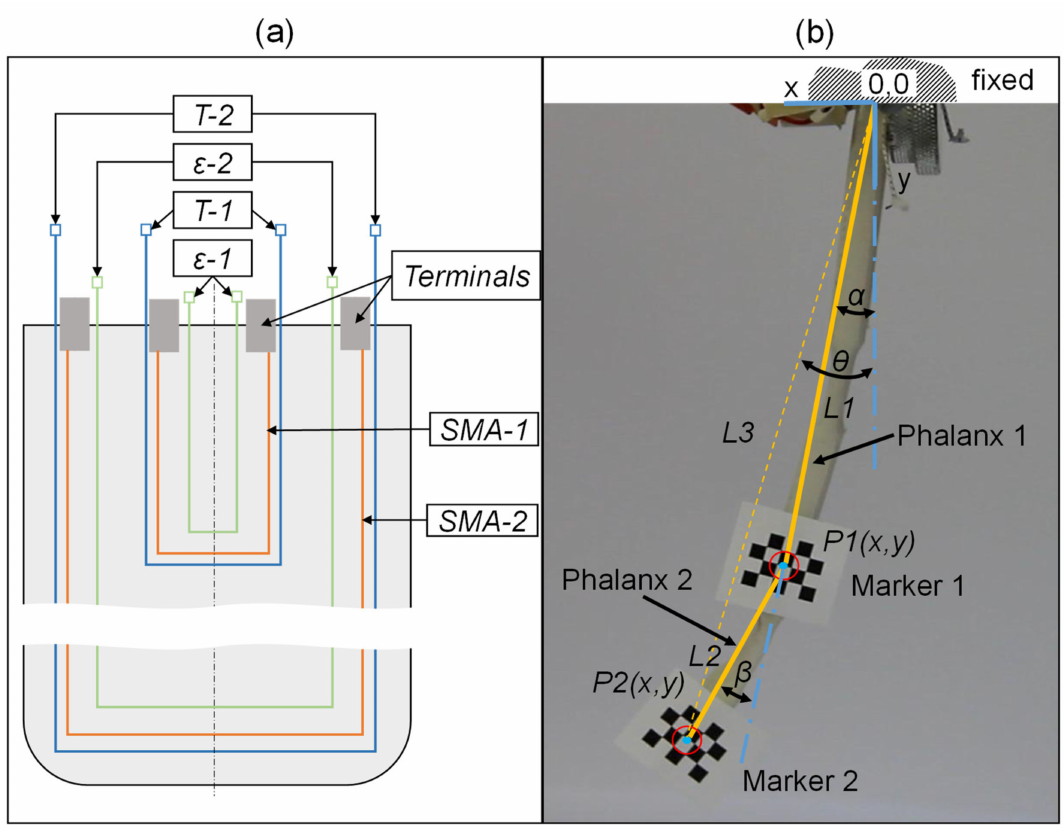
Figure 2. ( a ) Overview of the integrated sensors and actuators with copper wires as temperature sensors (T), braided silver-plated yarn as strain sensors ( ε ) and shape memory alloy wires (SMA) covering the first phalanx (1) and both first and second phalanx (2); ( b ) metrics to describe the phalanges position and